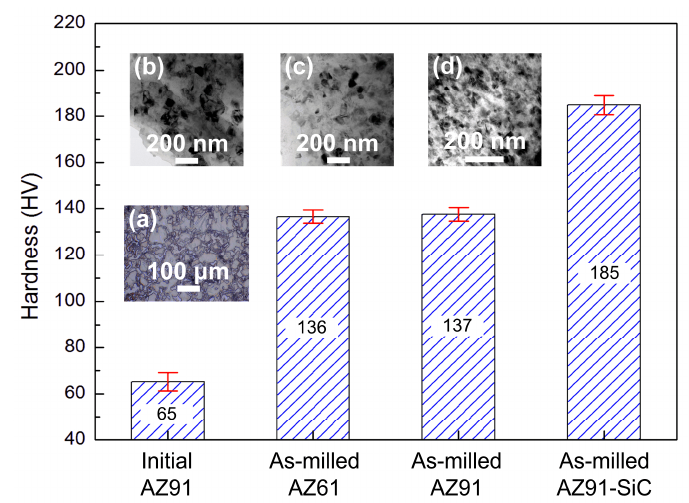
Figure 10. Hardness magnesium alloys with various states. ( a ) initial AZ91; ( b ) as-milled AZ61; ( c ) as-milled AZ91; ( d ) as-milled AZ91-SiC.